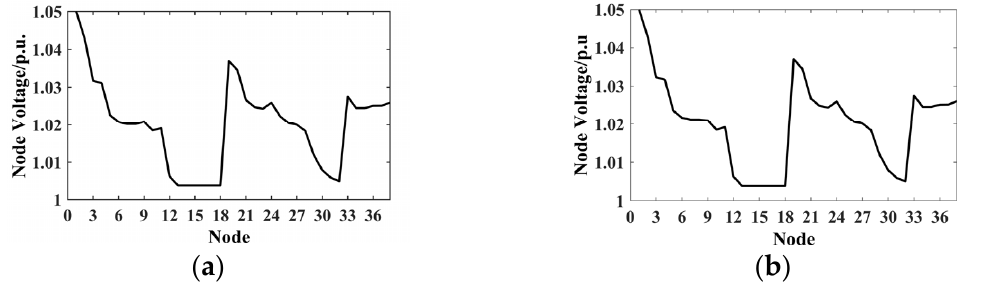
Weekdays, ( b ) Weekends. ( a )